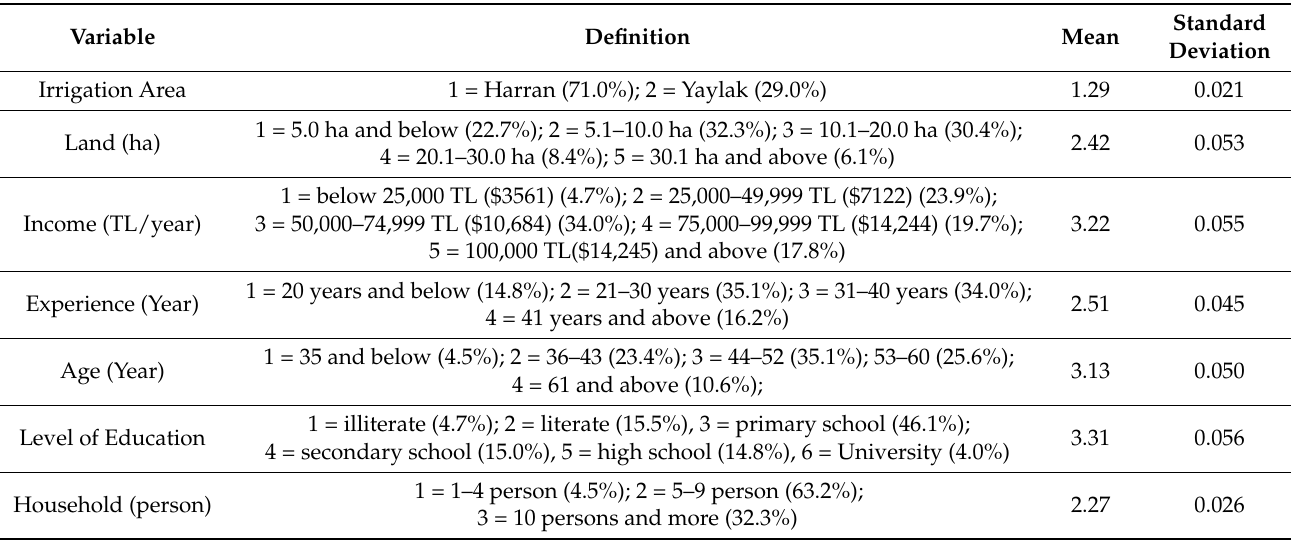
Table 1. Descriptive statistics of the surveyed